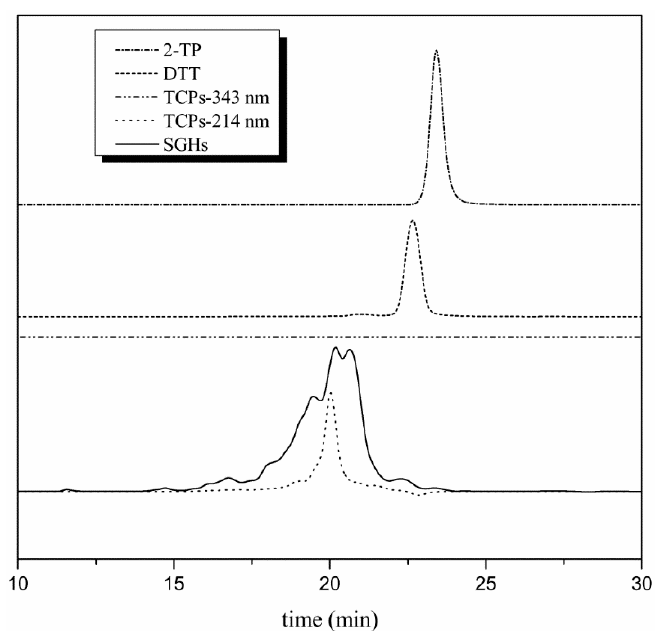
Figure 2. SEC-HPLC profile of reduced SGHs and TCPs. The Y axis was the absorbance of the elution at various wavelength and was omitted for the convenience of comparison between different compounds.